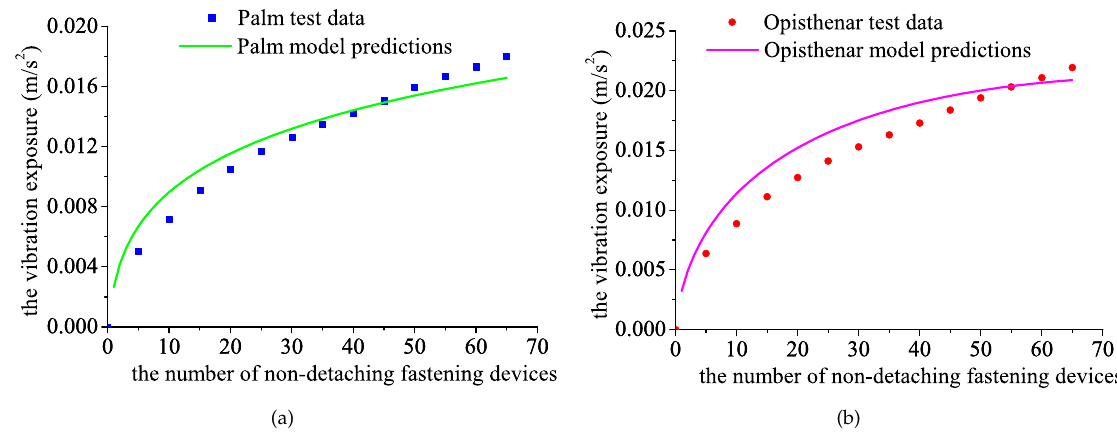
Figure 6. Comparison between the test data of vibration exposure using the 600mm operating rod and the results of the nonlinear prediction model: ( a ) Palm; ( b ) Opisthenar.